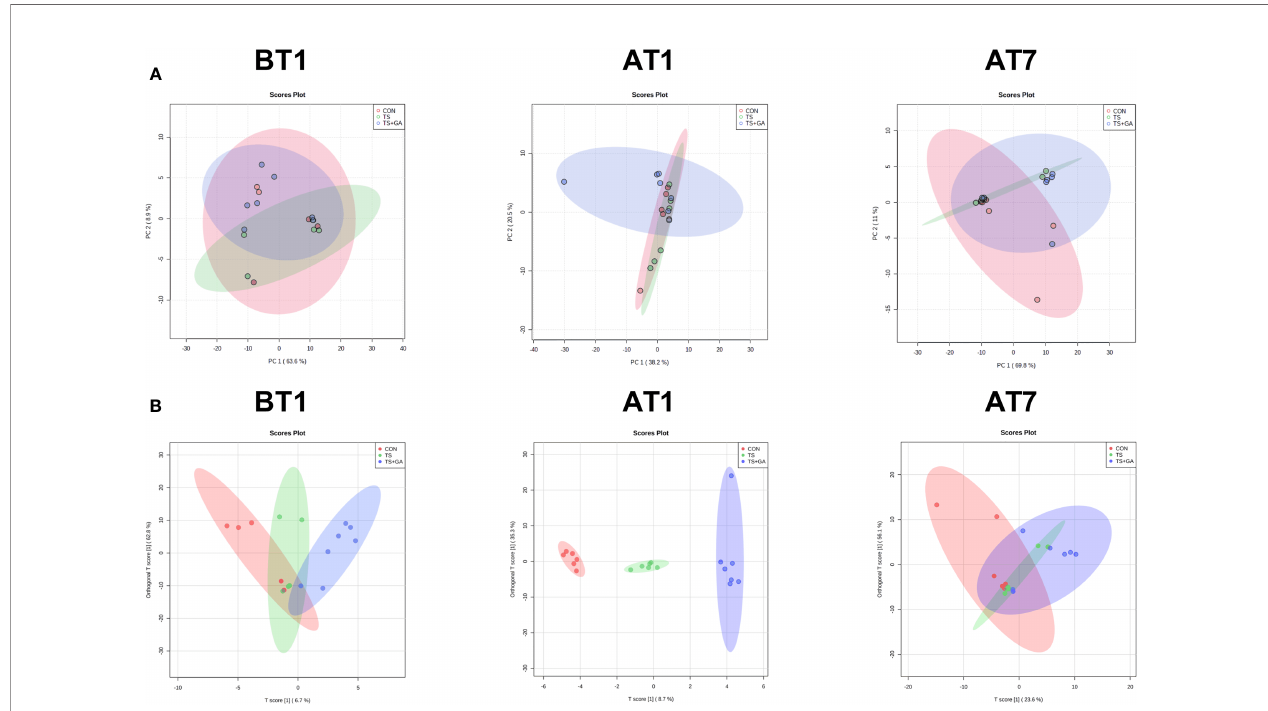
FIGURE 6 | Multivariate statistical analysis on BT1, AT1, and AT7 (n = 6 or 7). Score plots from the principal component analysis (PCA) model among three groups on BT1, AT1, and AT7 (A) . Score plots from the orthogonal partial least-squares discriminant analysis (OPLS-DA) model among three groups on BT1, AT1, and AT7 (B) . BT1, the 1st day before transportation; AT1, the 1st day after transportation; AT7, the 7th day after